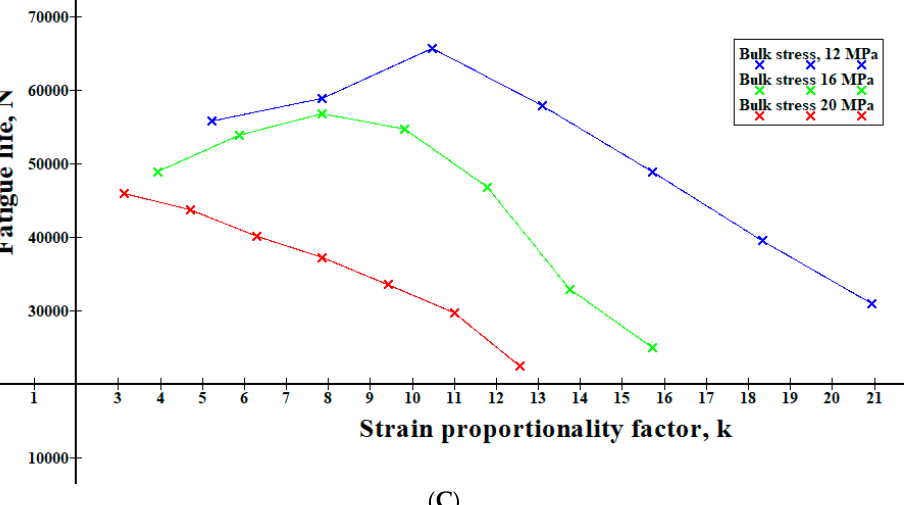
Figure 11. Relationship between ( A ) k and diametric strain, ( B ) k and longitudinal strain, ( C ) rela- tionship between fatigue life and strain proportionality factor.